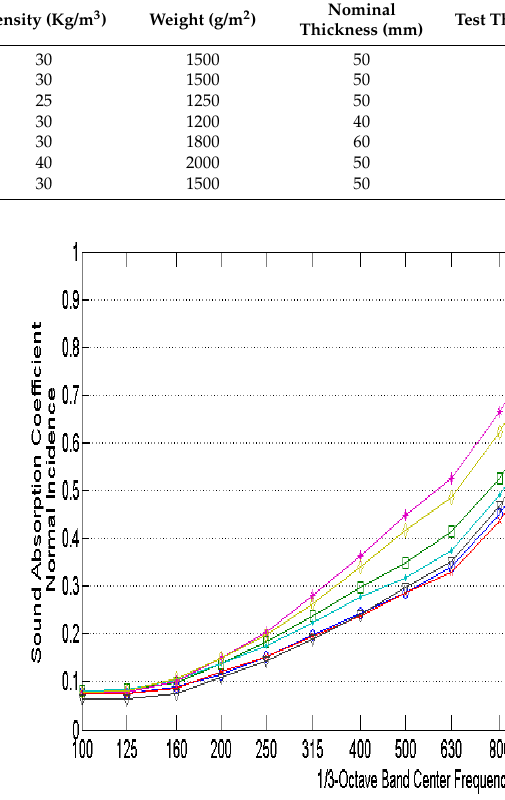
Figure 4. Measured normal incidence sound absorption coefficients.